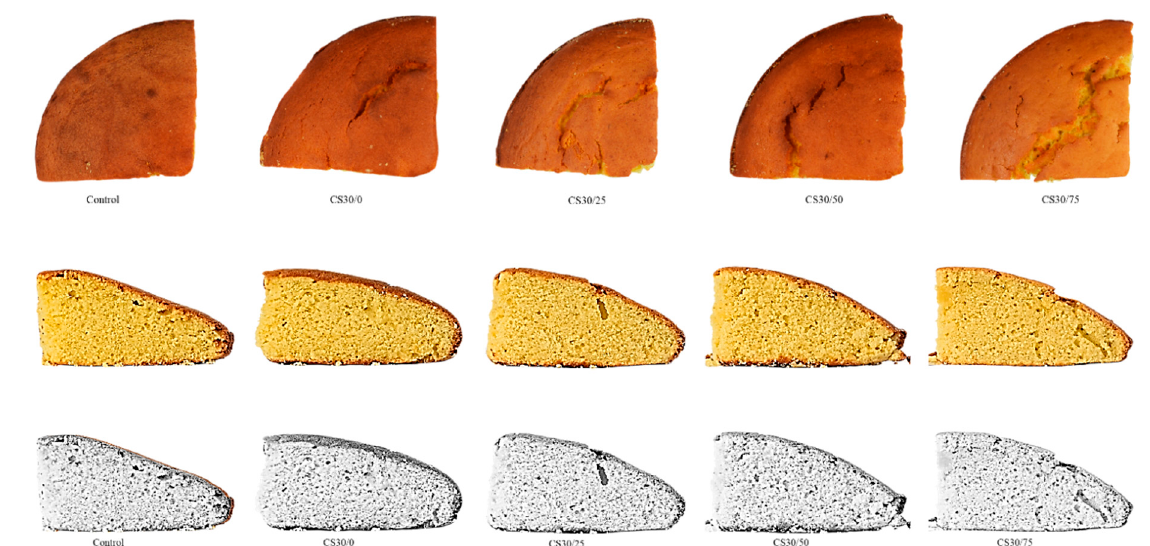
Figure 5. Top view (crust) and cross-section images of sponge cake fat reduced samples. From the left: control, S30/0, S30/25, S30/30, S30/50, S30/75.